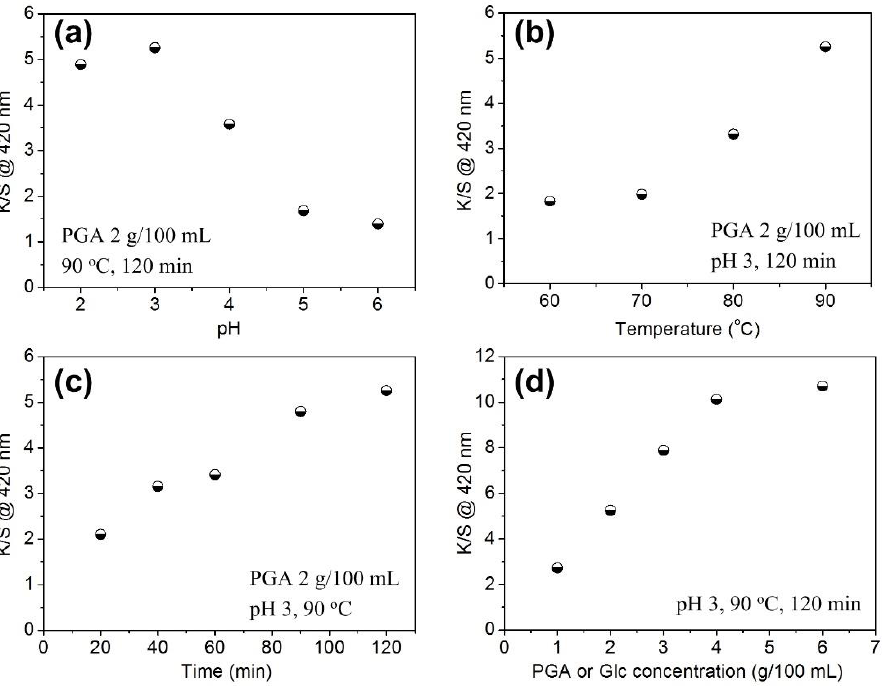
Figure 3. Dependence of the color depth of silk fabrics dyed with the PGA/Glc reaction products on pH ( a ), temperature ( b ), time ( c ), and PGA or Glc concentration ( d ) in the case of a PGA/Glc weight ratio of 1:1.